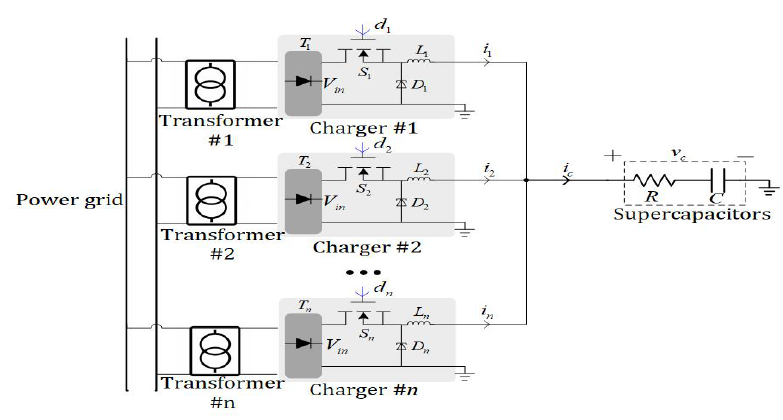
Figure 1. The layout of the multicharger